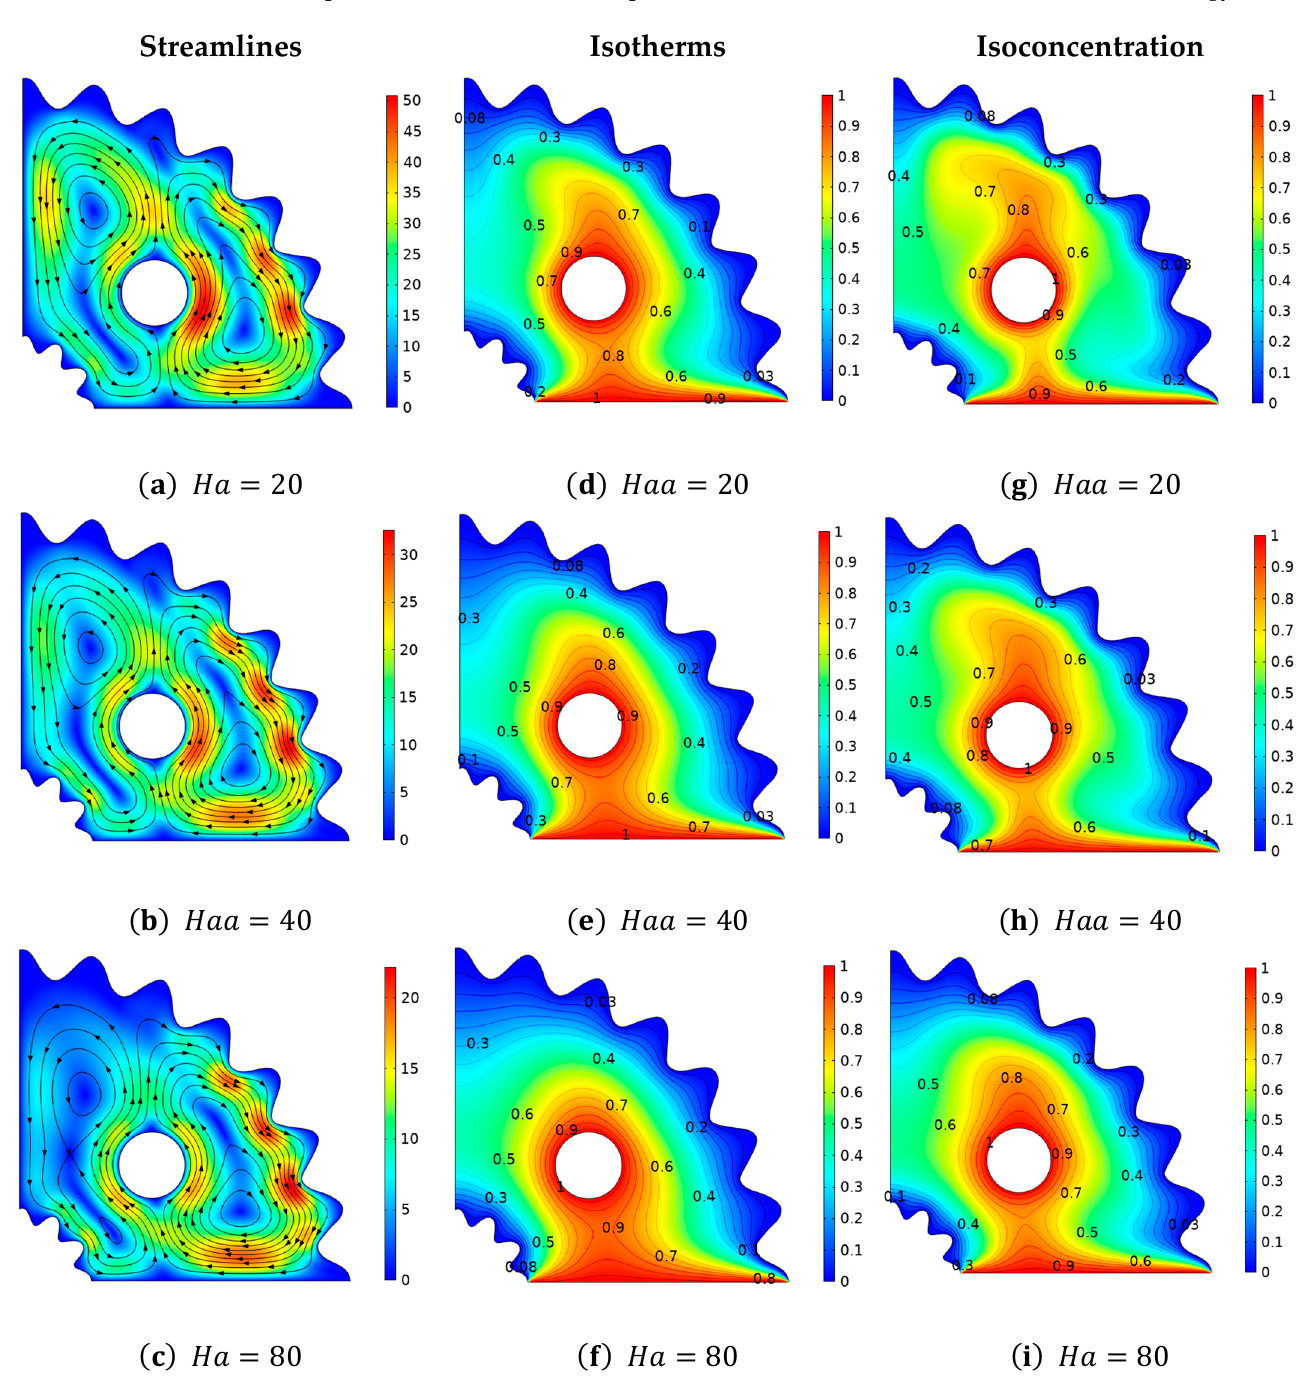
Figure 7. Deviation of ( a – c ) stream lines, ( d – f ) isotherms, and ( g – i ) isoconcentration with respect to the Hartmann number ( Ha ).